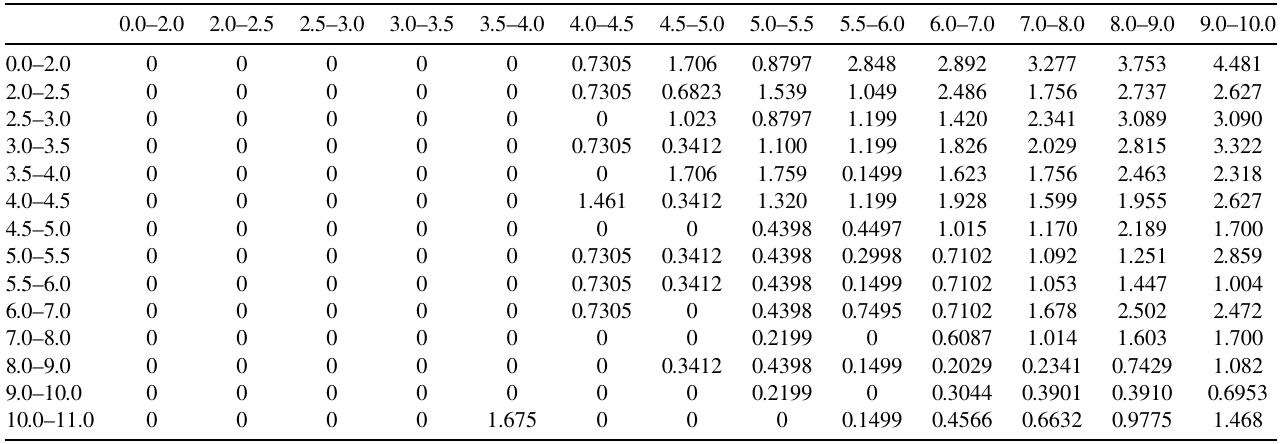
TABLE IX. (cid:4) þ background from (cid:3) (cid:5) CC events (all values (cid:2) 10 (cid:1) 4